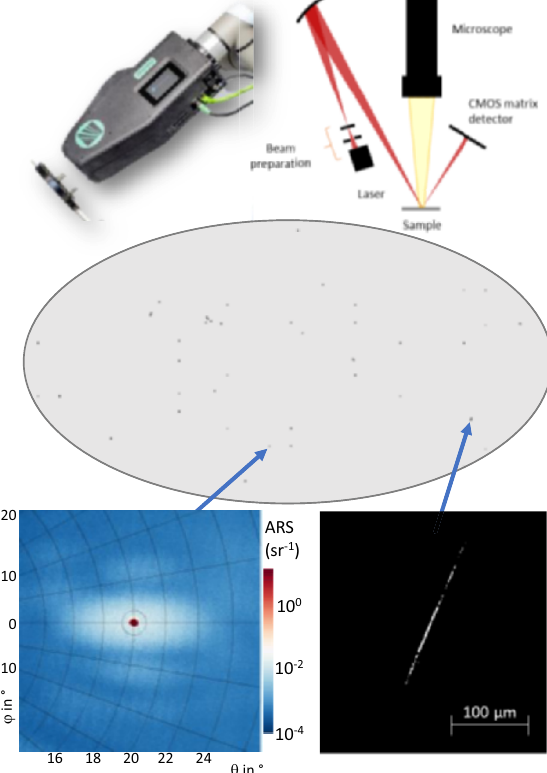
Fig. 2. Hybrid scattering sensor for imperfection assessment. Top: image and scheme of the sensor. Middle: binarized imperfection mapping of an ellipsoidal mirror substrate (120 x 70 mm²). Bottom: typical 3D-ARS image of a defect (left) and microscopy image of a scratch (right).